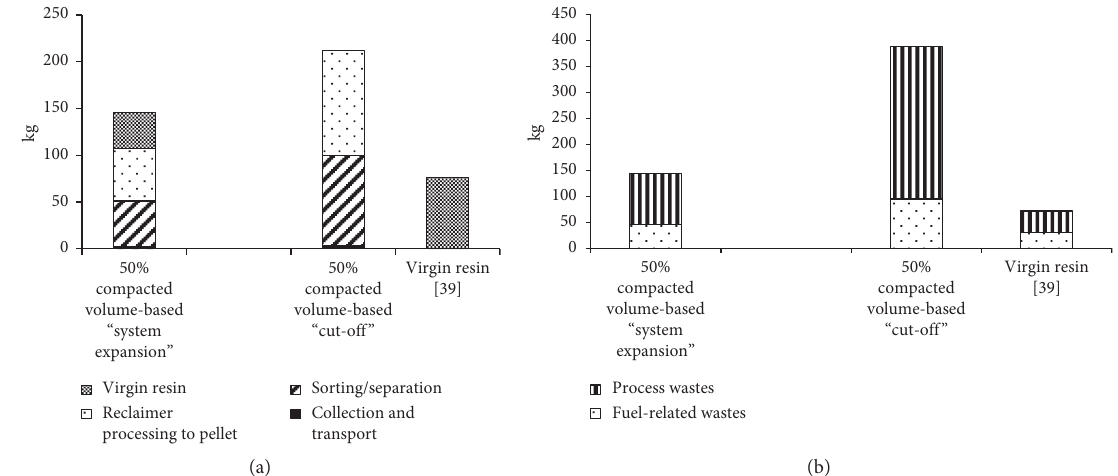
Figure 7: Solid waste results for production of the recycled HDPE resin pellet (kg per ton of resin) by the (a) life cycle stage and (b) solid waste